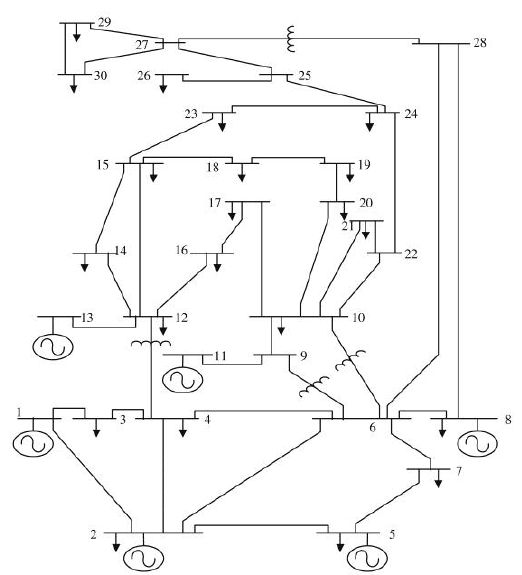
Figure 3. IEEE 30-bus test system